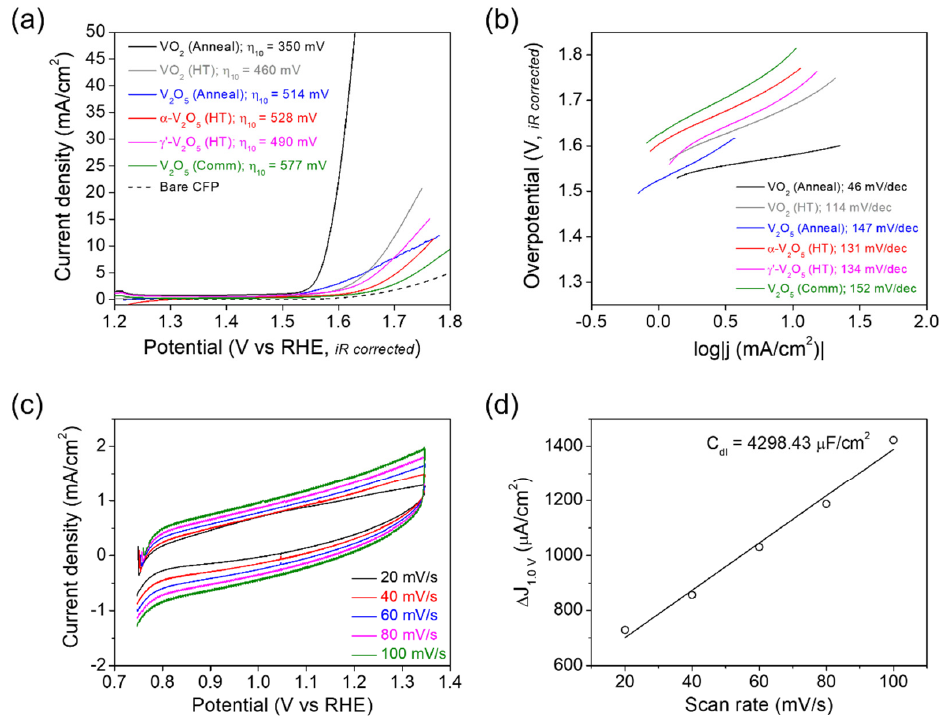
Figure 3. ( a ) Polarization curves and ( b ) Tafel plots measured for the vacuum-annealed VO 2 (M1) and V 2 O 5 , hydrothermally grown VO 2 (M1), α -V 2 O 5 , and γ′ -V 2 O 5 , and commercial V 2 O 5 , prepared on carbon fiber paper, contrasted to data acquired for bare CFP. The data have been acquired in aqueous solutions of 1 M KOH using a three-electrode assembly. ( c ) Cyclic voltammograms acquired at various scan rates for the VO 2 (M1) nanoparticles formed on carbon fiber paper. ( d ) The differences in current density ( ∆ j = j a − j c ) at 1.0 V versus RHE are plotted as a function of the scan rate. The C dl value is extrapolated from a linear fit to the